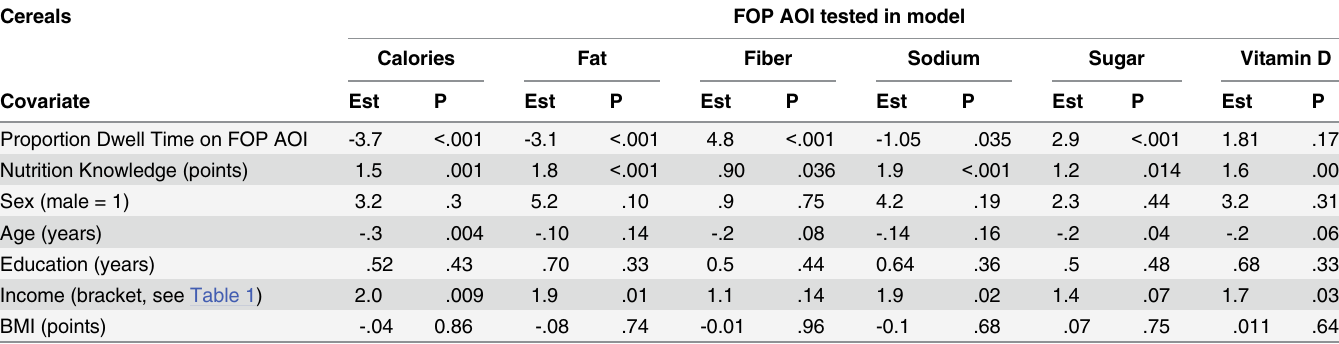
Table 4. Estimated effects of dwell time on accuracy, tested separately for each area of interest (AOI) for cereals.